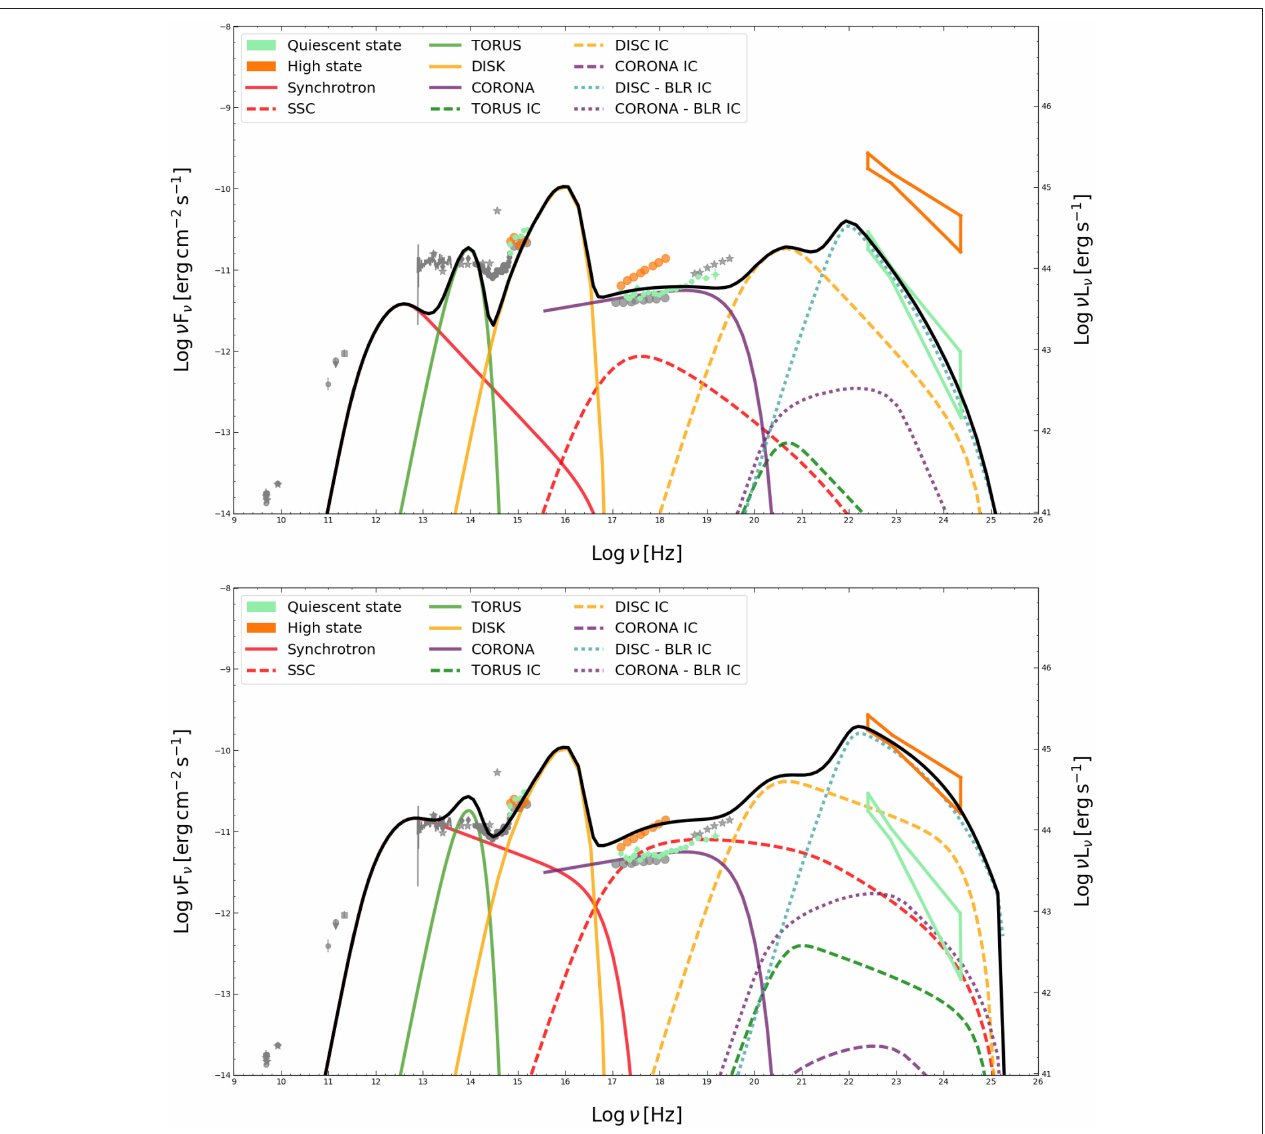
FIGURE 2 | Multi-component model for the quiescent state (Top) and the flaring state (Bottom) of 1H 0323 + 342. The quiescent state is depicted in light green, and the flaring state in orange. The bow-ties in the 10 22 –10 25 Hz range represent Fermi/LAT spectrum and corresponding uncertainties. Archival data are represented in gray. Synchrotron and SSC emission from the jet are shown by solid and dashed red lines respectively. Direct emission from the torus, the accretion disc and the X-ray corona is shown in green, yellow and purple solid lines respectively. Torus, accretion disc and corona IC emission follow the same color code and are represented by dashed lines. BLR reprocessed disc and corona components are shown in dotted blue and purple, although their contribution is negligible in both cases. The total model is depicted with a black solid